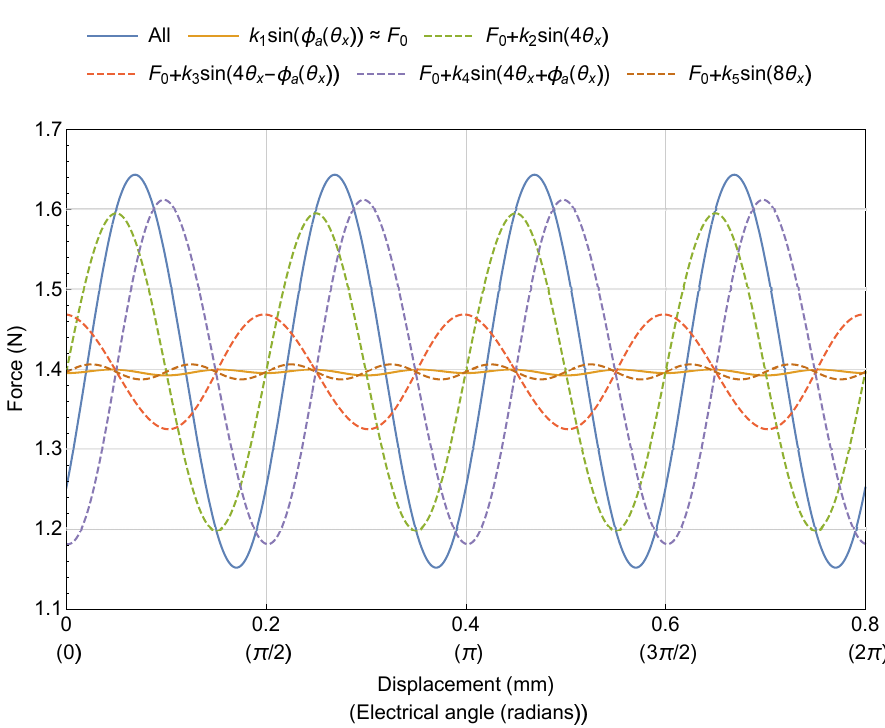
Figure 5. Model thrust force output throughout one displacement period, considering different force harmonic components. The coefficient k n represents the amplitude of each harmonic, as per (25). The average value of k 1 sin ( φ a ( θ x )) is defined as F 0 , which is equal to k 1 and is approximately 1.4 N. Table 3. Parameters used for the motor model when comparing with experimental results. Values within parenthesis indicate total measured range.